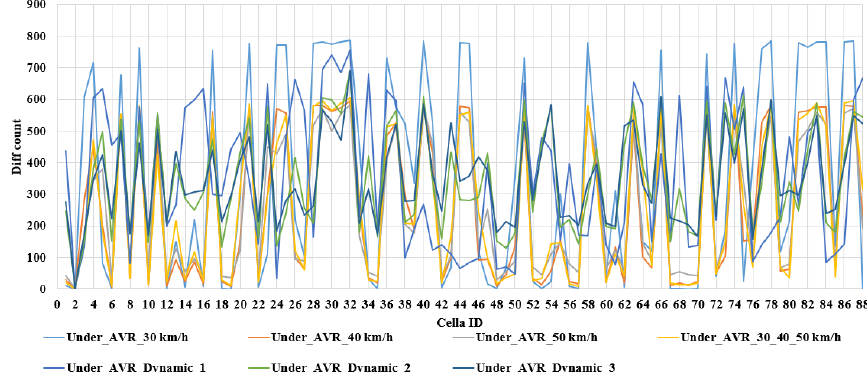
Figure 11. Number of deviations from the average voltage. Figure 11 indicates the number of discrepancies on the vertical axis and the cell ID on the horizontal axis. A relatively large number of cells deviate from the mean, and some deviate in 90% of the measurements. However, in this analysis, deviations of smaller or- ders of magnitude of mV (‘millivolt’) are also counted. Therefore, in the following, the authors have examined the difference between the average voltage of 12 mV (1% of the measurement range), 60 mV (5% of the measurement range), and 120 mV (10% of the measurement range), i.e., how many times the cells deviate during the different tests; see Figure 12.